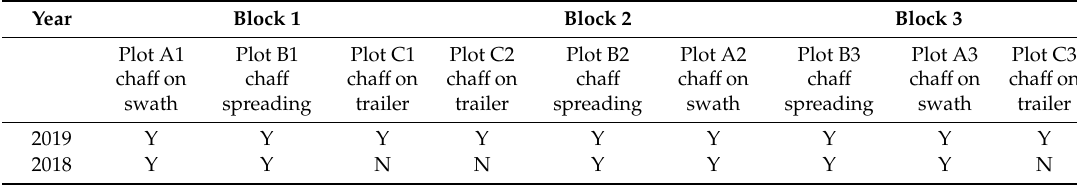
Table 2. Experimental design (2 treatments in 2018: A and B modes; and 3 treatments in 2019: A, B, and C